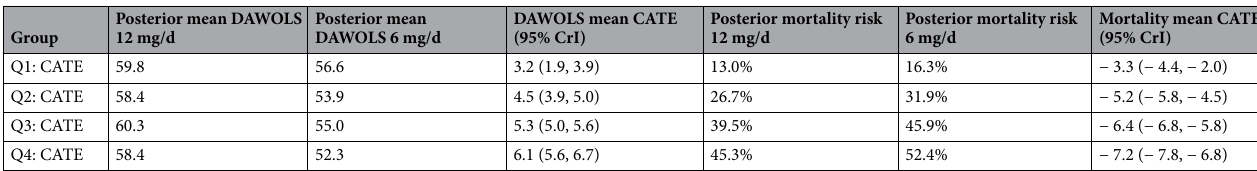
Table 2. Treatment effect summaries for subgroups defined by quartile of estimated treatment effect for each of (1) estimated mean difference in days alive without life support at 90 days and (2) estimated mortality risk difference. To briefly summarize, this table complements Fig. 1 and shows that 12 mg/d is associated with greater benefit for both outcomes compared to 6 mg/d. Figure 1 shows the results for each individual,